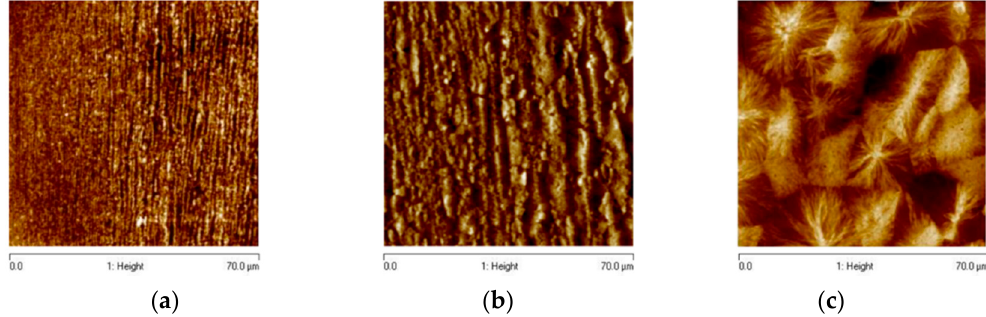
Figure 6. Atomic Force Microscopy (AFM) images over an area of 70 µ m × 70 µ m at 0.25 mm ( a ), at 0.38 mm ( b ), and 0.7 mm ( c ) from the sample surface for the test 80-07. At 0.25 mm, morphological elements aligned along the flow direction tightly packed can be observed. At 0.38 mm, the average diameter of the morphological elements aligned along the flow direction range from about 4 µ m to about 6 µ m. At 0.585 mm, spherulitic structures cover the whole investigated area.